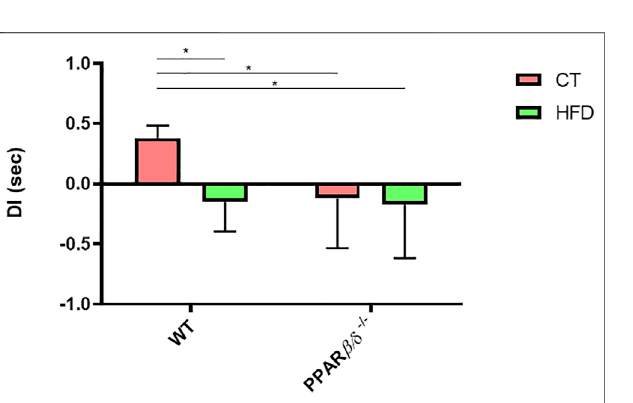
Therefore, our results indicated that HFD feeding induces memory alterations in WT. However, when animals exhibit PPAR β / δ de fi ciency memory pro fi le was similar, but it was not enhanced by the diet.